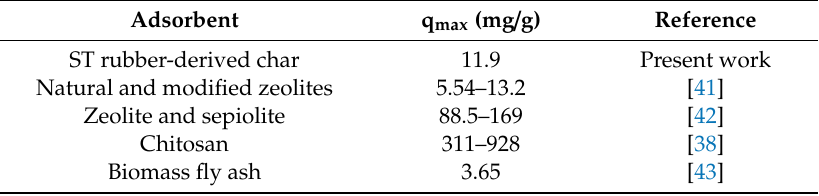
Table 4. RY uptake capacities of different adsorbent materials found in the literature.